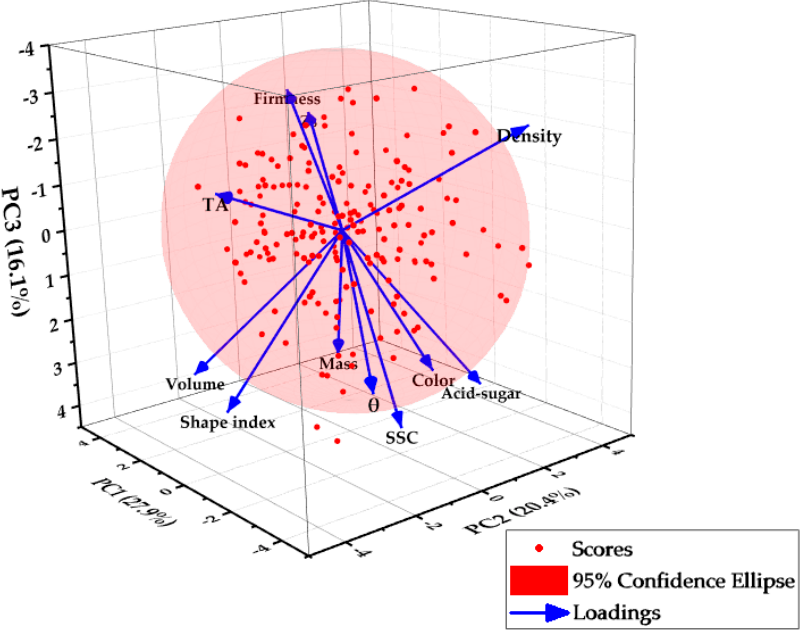
Figure 6. Principal component analysis (PCA) plot of the first (PC1), second (PC2), and third principal components (PC3). Table 2. Percentage of total variance explained.